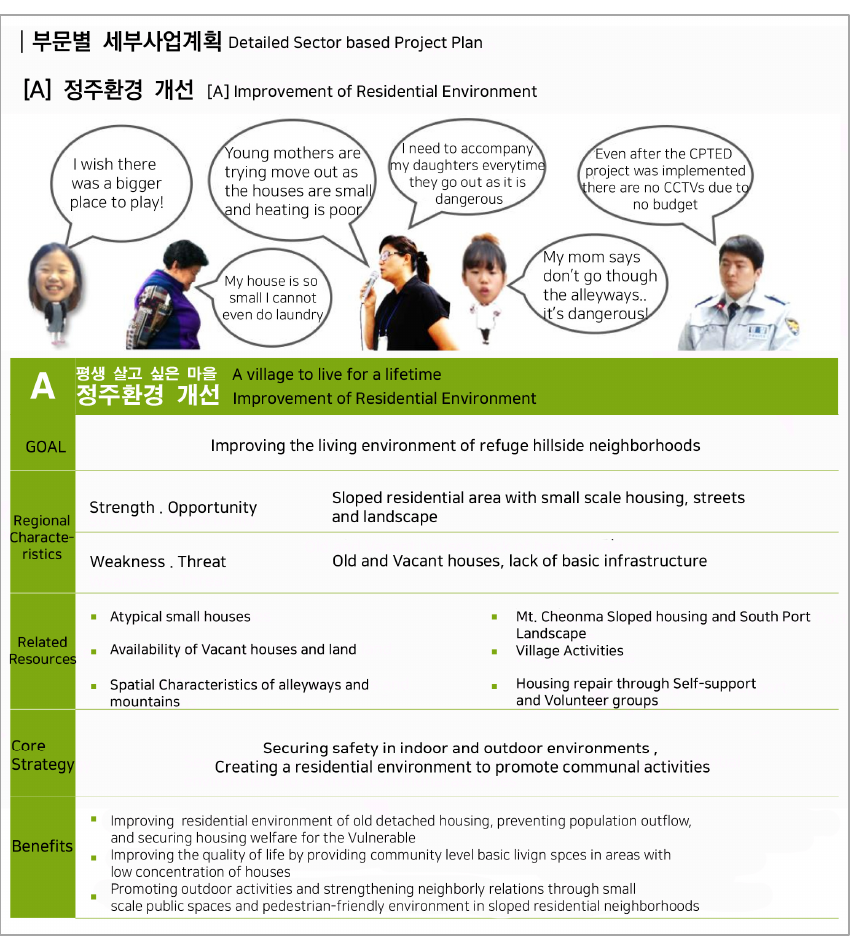
Figure 14. How people’s dialogues were documented and used for making regeneration proposals [48]. Adapted with permission from Amichojang Dosijaesaeng Peurojekteu [Ami-Chojang Urban Regeneration Project]. 2016, by S.-K.,